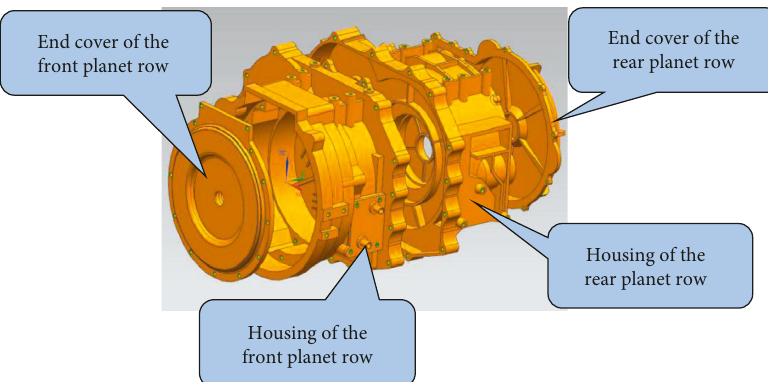
Figure 4: Housing of the power coupling mechanism.